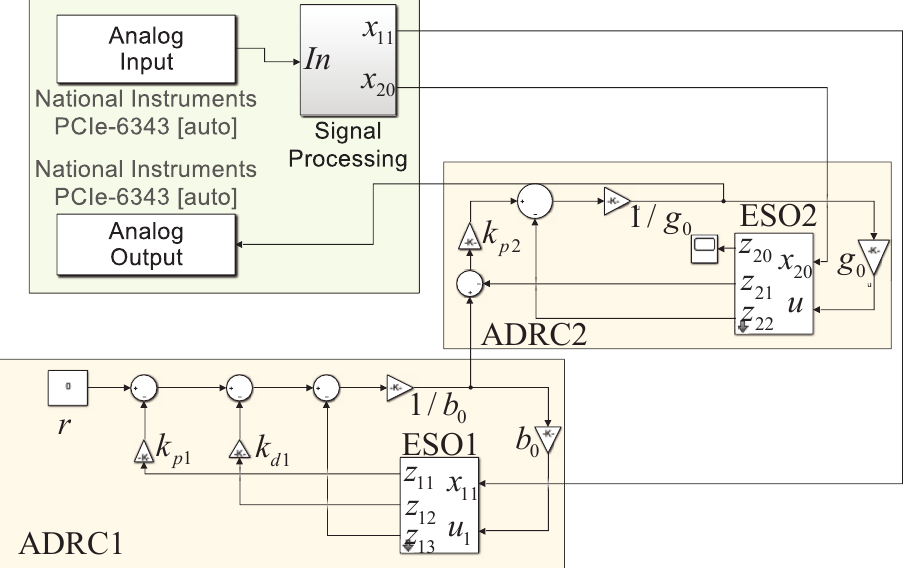
Figure 5. Real-time simulation model of cascade ADRC in